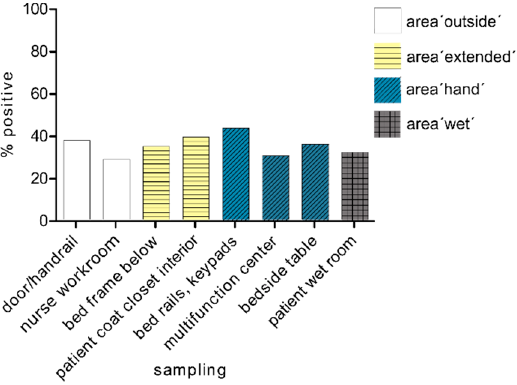
Figure 2. Spread after 24 h. Spread of carbapenemase-positive organisms within the four tested areas after 24 h of hospitalisation of the patient in the room ( n = 21–30).